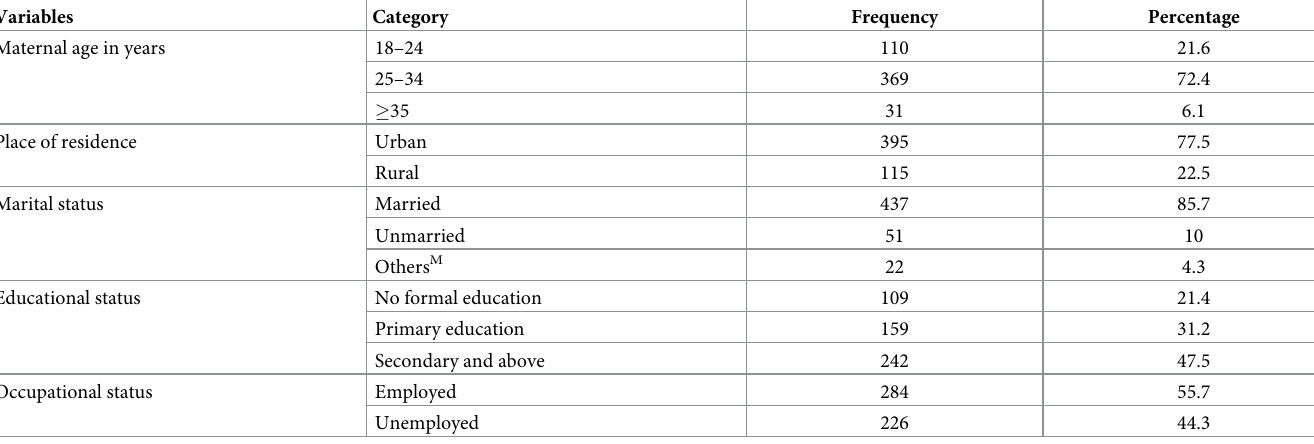
Table 1. Socio-demographic characteristics of pregnant woman attending antenatal care clinic at Gondar town, Northwest Ethiopia, 2021 (n = 510).